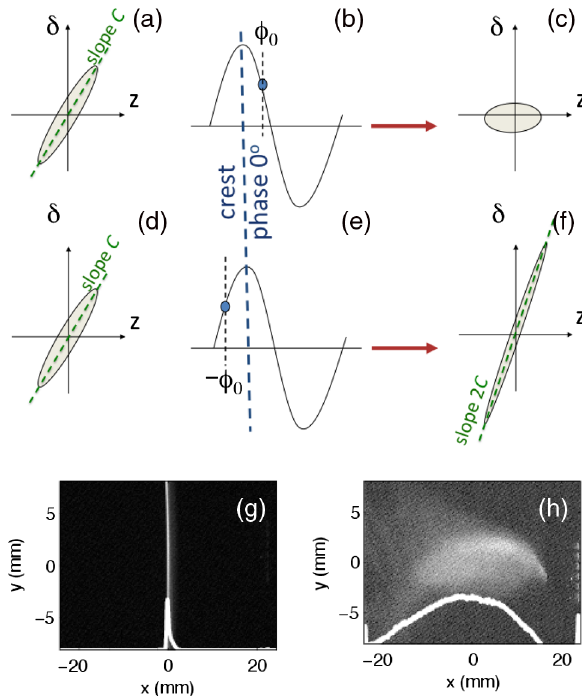
FIG. 9. Principle of measurement of the LPS chirp [(a), (b), and (c)] and bunch length [(d), (e), and (f)] measurements. The left [plots (a), (d)], middle [plots (b), (e)], and right [plots (c), (f)] columns show respectively the initial LPS, the location of the bunch (shown as a blue circle) w.r.t. the accelerating voltage, and the final LPS. The images (g) and (h) respectively show an example distribution measured at the XS3 location for minimum-energy-spread and off-crest phase settings; see text for details. In these latter images the horizontal axis corresponds to the energy-dispersed direction [ x ½ mm (cid:7) ’ 317 (cid:9) where (cid:9) is the unitless fractional momentum spread].